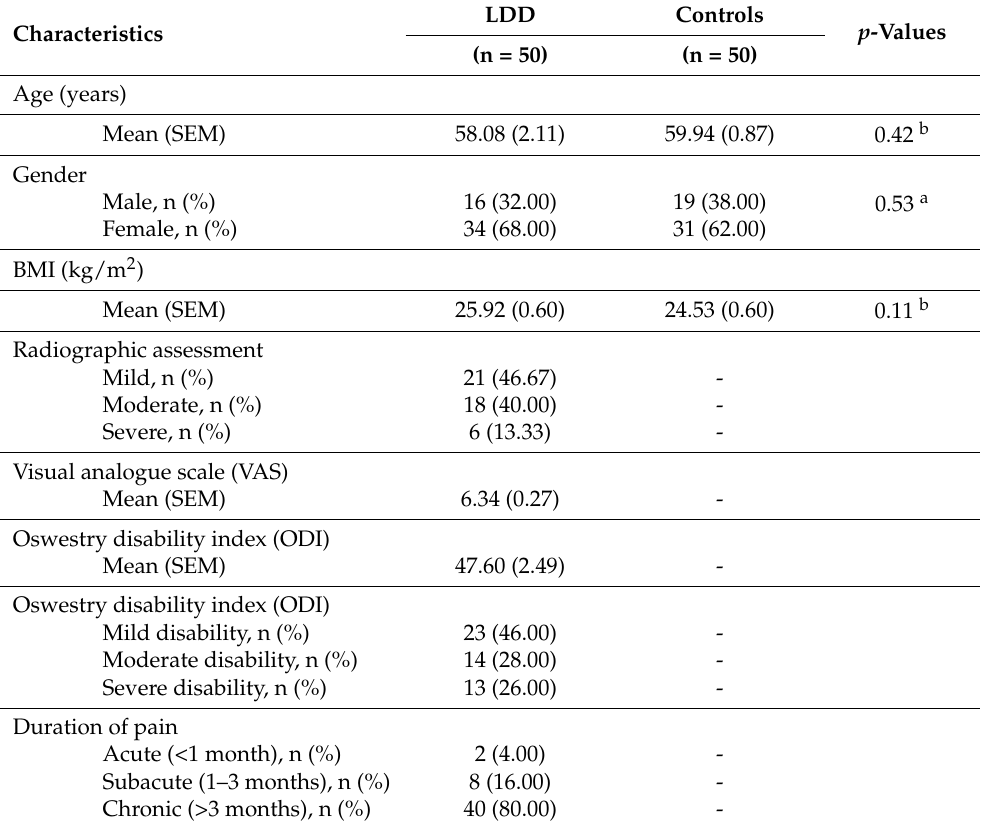
Table 1. Baseline characteristics of LDD patients and healthy